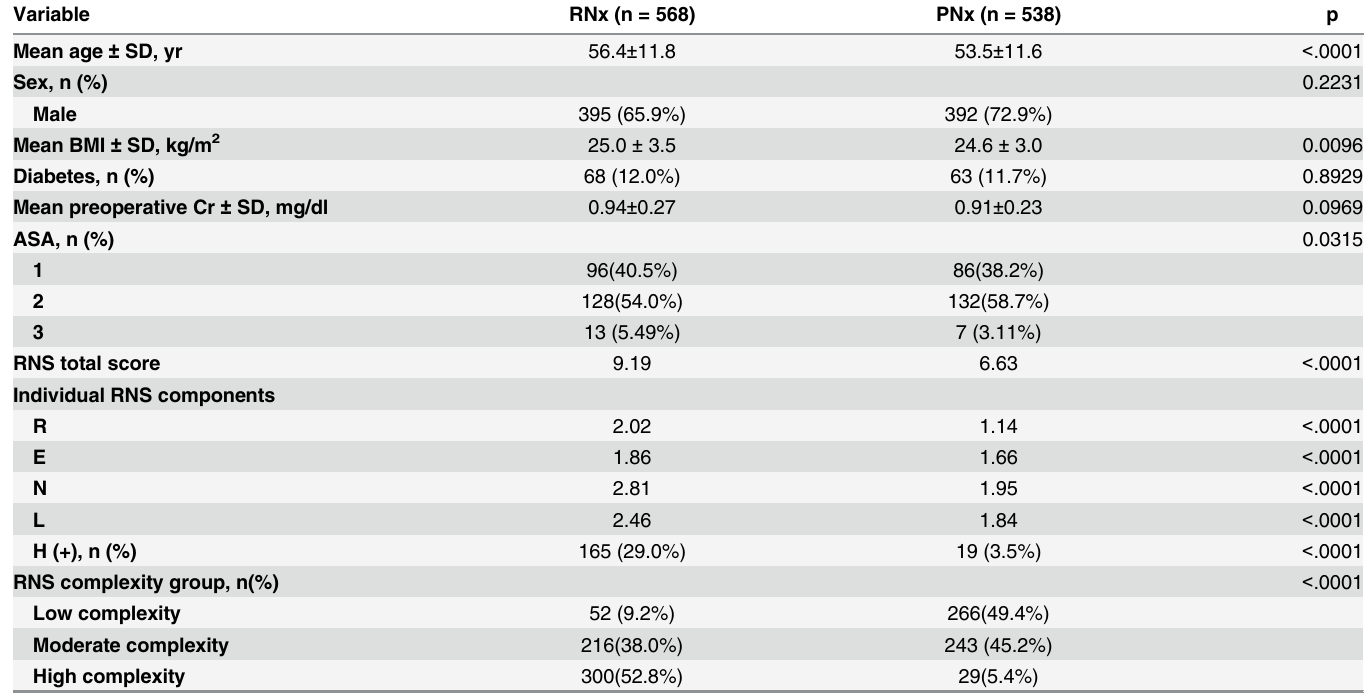
Table 3. Comparison of patients managed by radical nephrectomy and partial radical nephrectomy. Variable